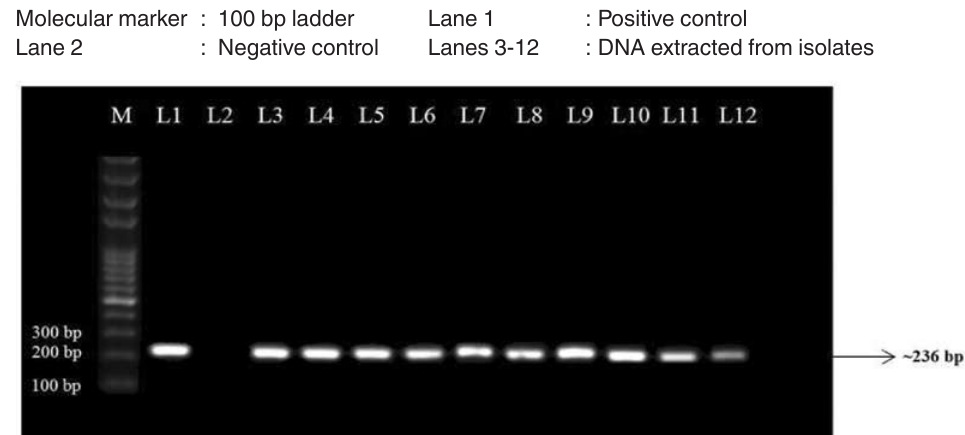
Fig. 5. PCR amplicons of GyraseB gene of Leptospira